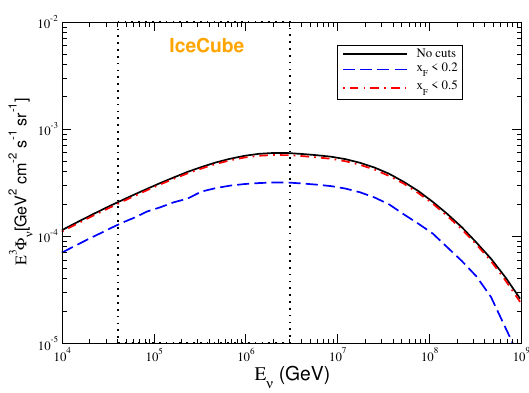
Figure 4. The e ff ect of x F cuts on the prompt neutrino